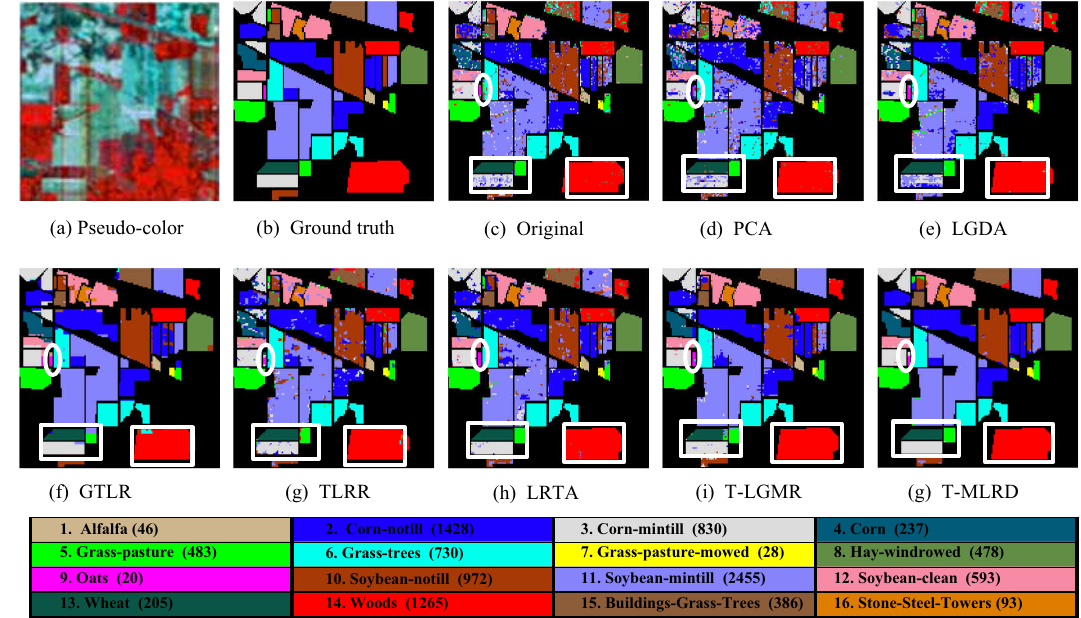
Figure 4. Classification maps of different methods on the Indian Pines